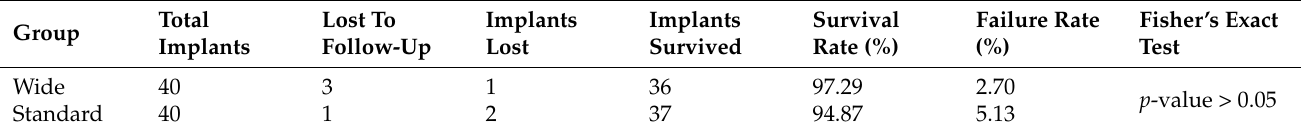
Table 2. Six-year survival and failure